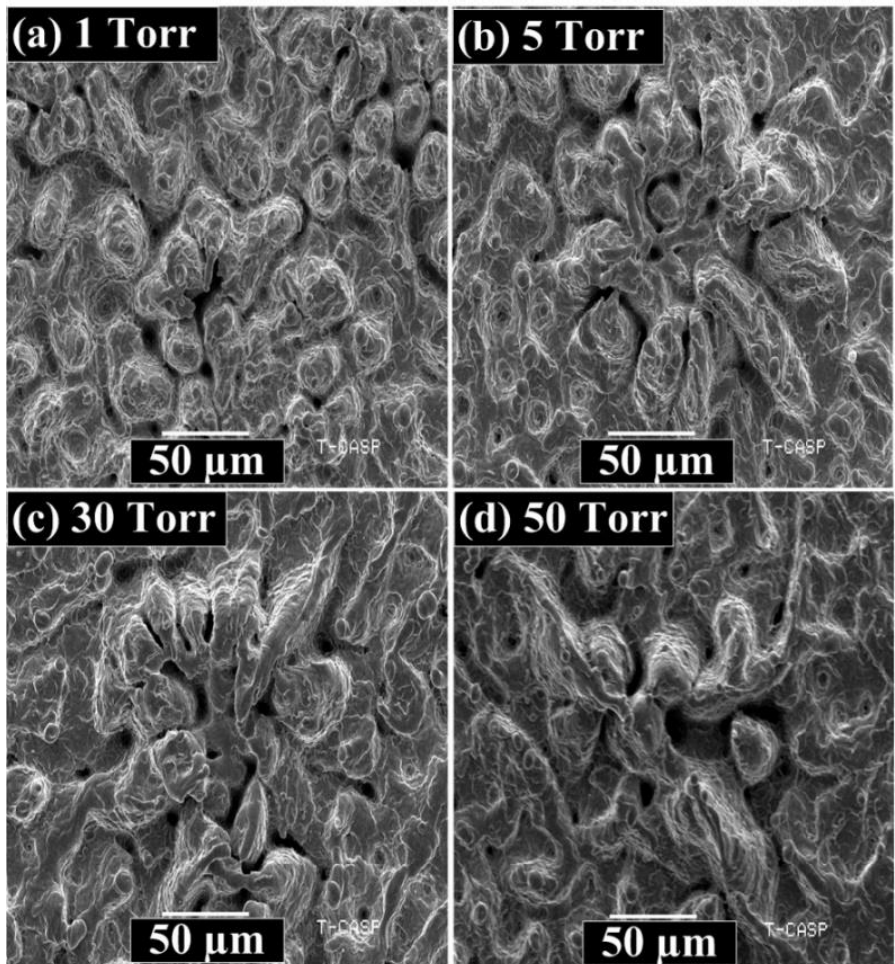
Figure 14. SEM micrographs demonstrating surface morphological changes in a He ambient envi- ronment at ( a ) 1 torr, ( b ) 5 torr, ( c ) 30 torr, and ( d ) 50 torr with 3.8 GW/cm 2 laser irradiation in the field-free condition.